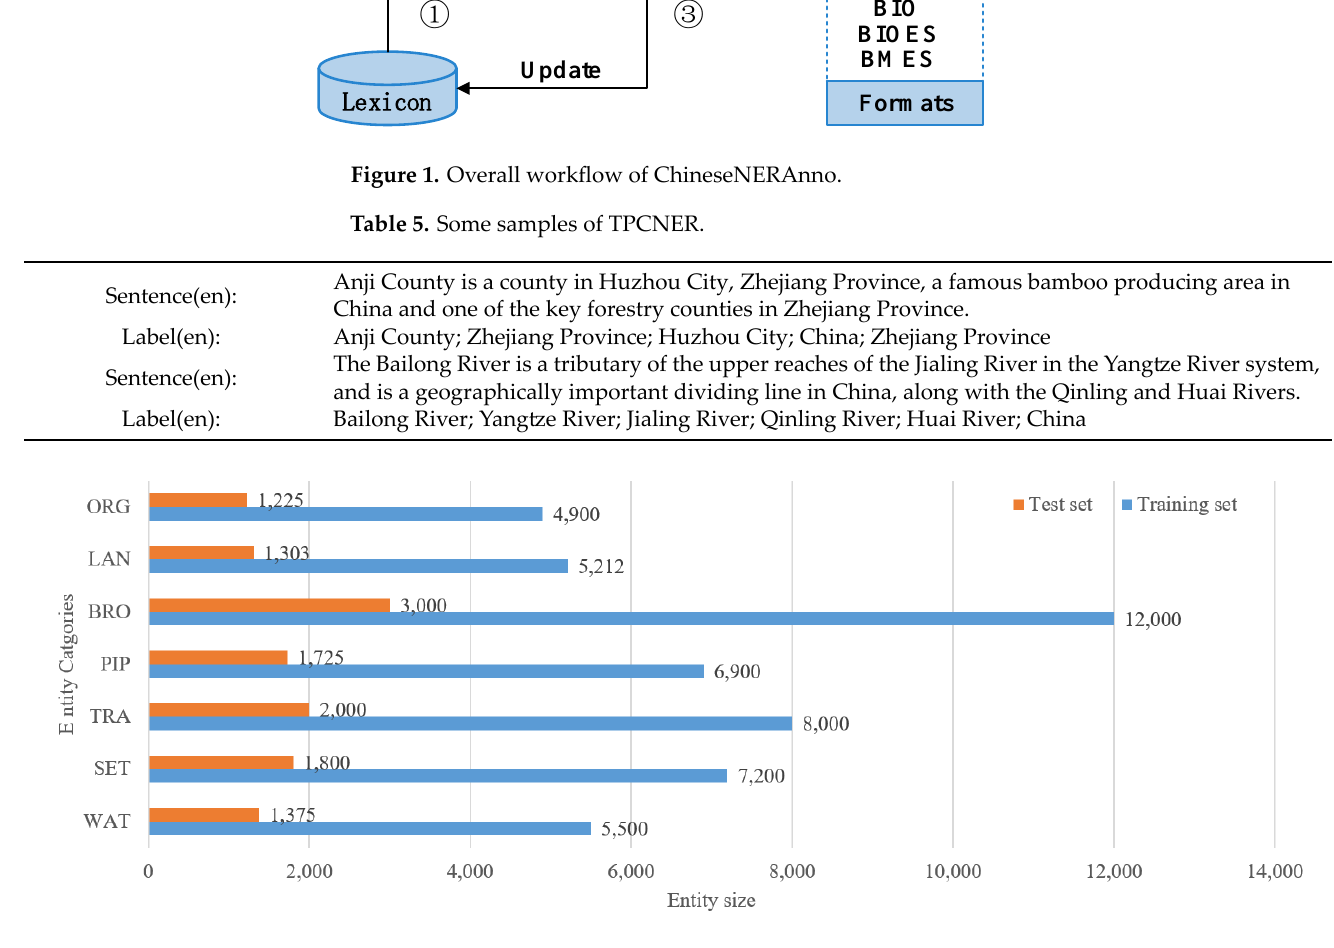
Figure 2. Distribution for each category in Table 6. Comparative information between TPCNER and other datasets.